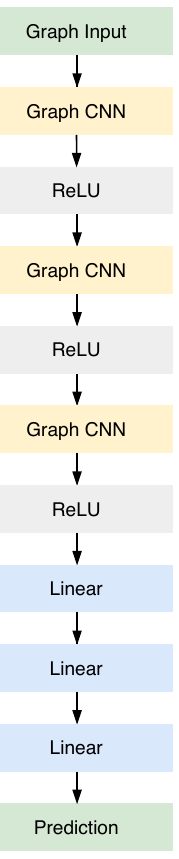
Figure 2. Model structure, showing the layers that comprise the proposed neural network for intentional